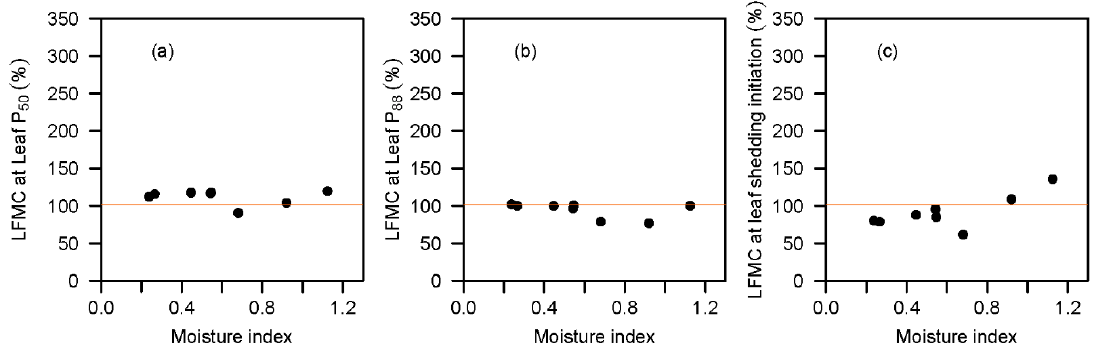
Figure 7. Value of LFMC at ( a ) leaf P 50 , ( b ) leaf P 88 and ( c ) initiation of leaf shedding (when up to 10% leaf shedding had occurred) for eight species of Eucalyptus . The y -axis range is the same as for Figure 3, to illustrate the range of LFMC values observed in the case study. The horizontal lines represent the LFMC threshold (~102%) associated with a step-change in fire activity for south-eastern Australian eucalypt forests and woodlands (see [9]).